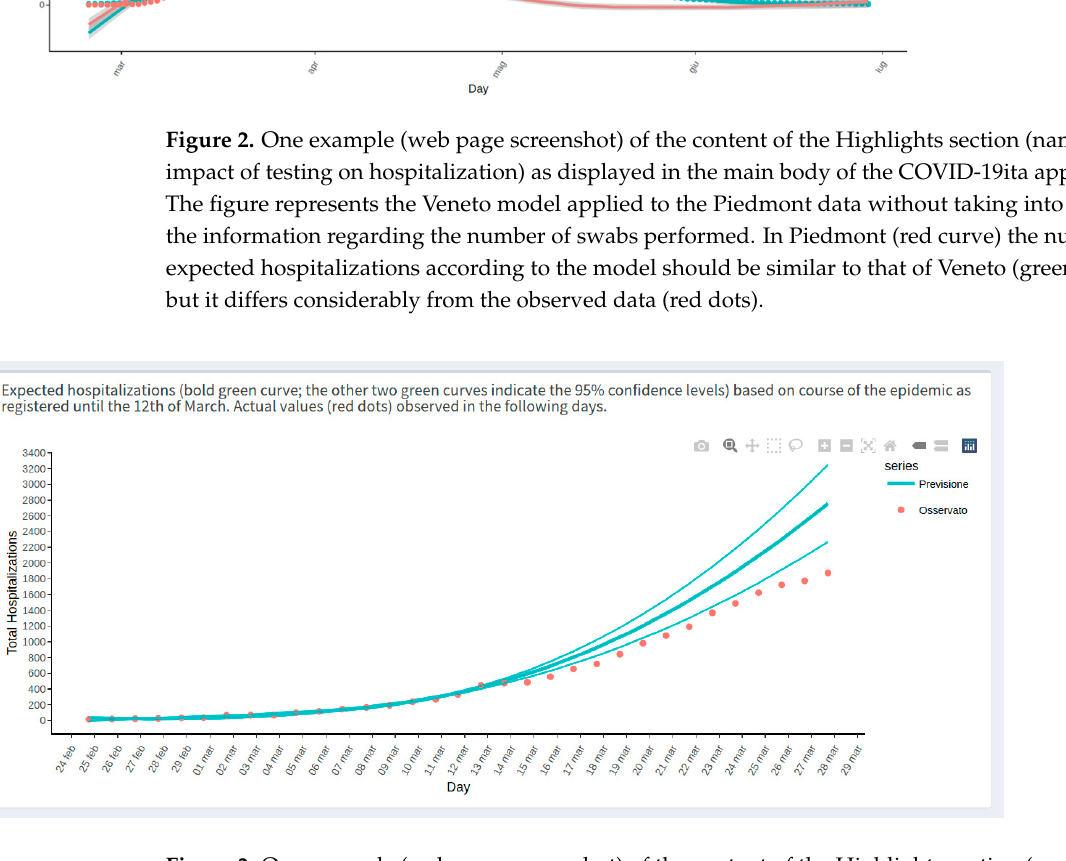
Figure 3. One example (web page screenshot) of the content of the Highlights section (namely, the possible effect of the health policies implemented by the Veneto region) as displayed in the main body of the COVID-19 pandemic